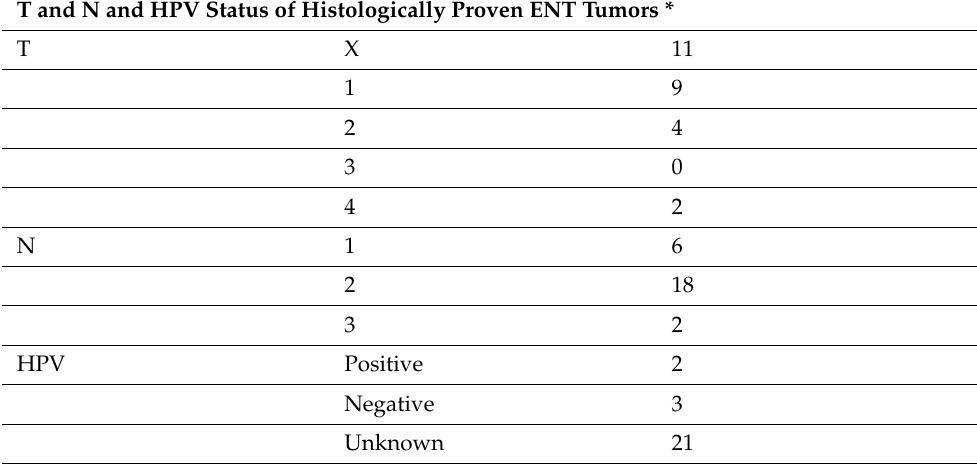
Table 2. T and N and HPV status of histologically proven ENT tumors.